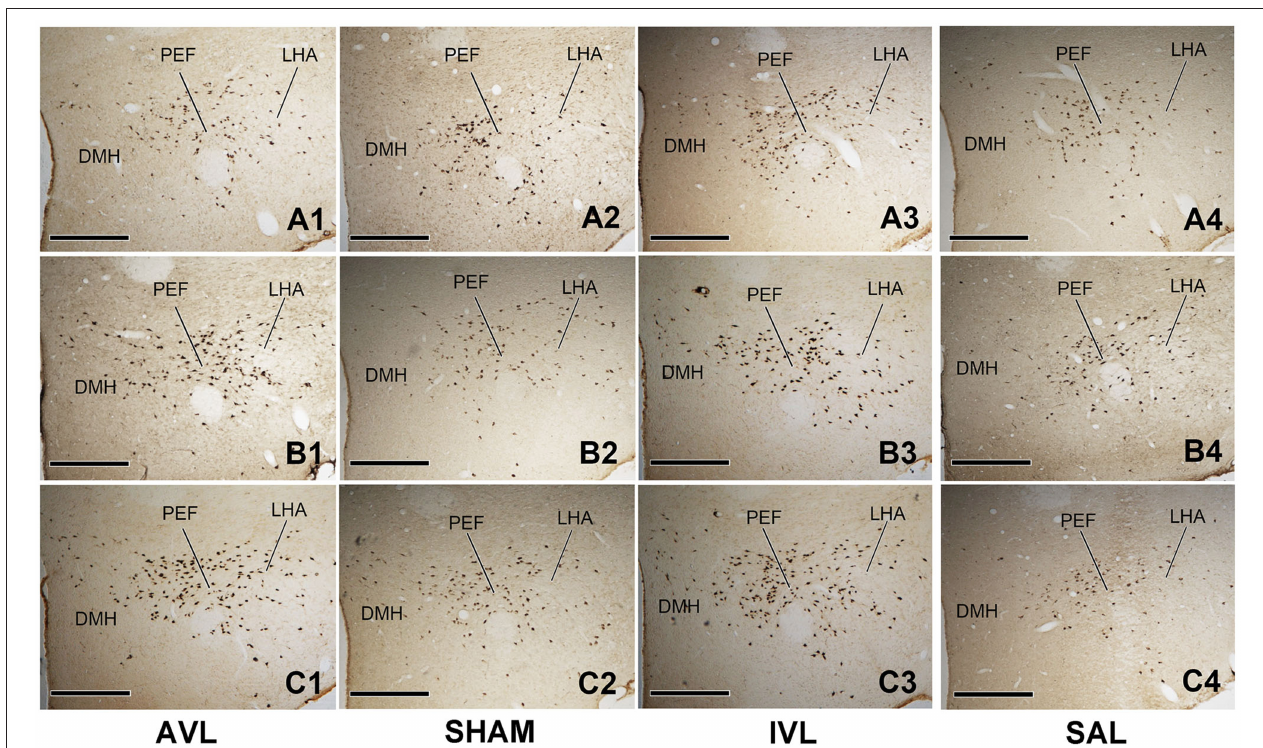
FIGURE 1 | Representative photomicrographs showing orexin-A-labeled (OXA-LI) neurons in rat hypothalamus (Bregma − 2.6 ∼ − 3.0mm) in the arsanilate-induced vestibular lesion (AVL), the sham control (SHAM), the IDPN-induced vestibular lesion (IVL), and the saline control (SAL) groups at 24h (A1–A4), 48h (B1–B4), or 72h (C1–C4) after recovery from vestibular lesion or control treatment. LHA, lateral hypothalamic area; PFA, perifornical area; DMH, dorsomedial hypothalamus. Bar = 400 µ